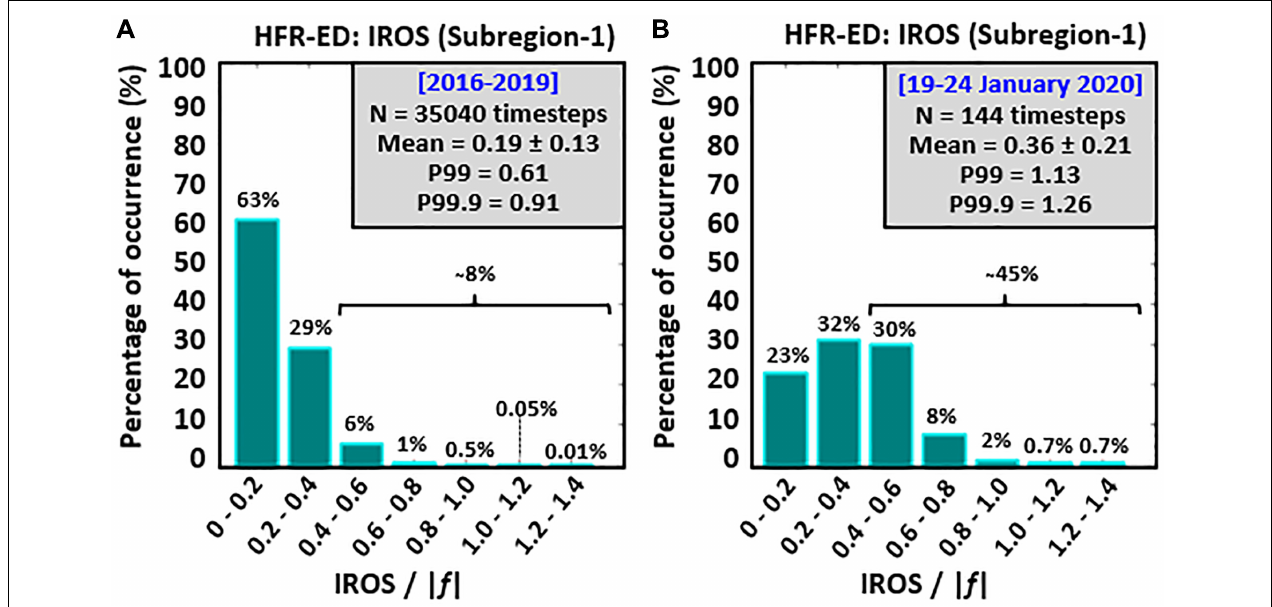
FIGURE 10 | Histogram of the Instantaneous Rate of Separation (IROS), derived from HFR-ED hourly current estimations and spatially averaged over the subregion-1 (defined in Figure 7A ) for: (A) the entire historical dataset (2016–2019); (B) the 6-day period when storm Gloria impacted on the Ebro Delta (January 19–24,